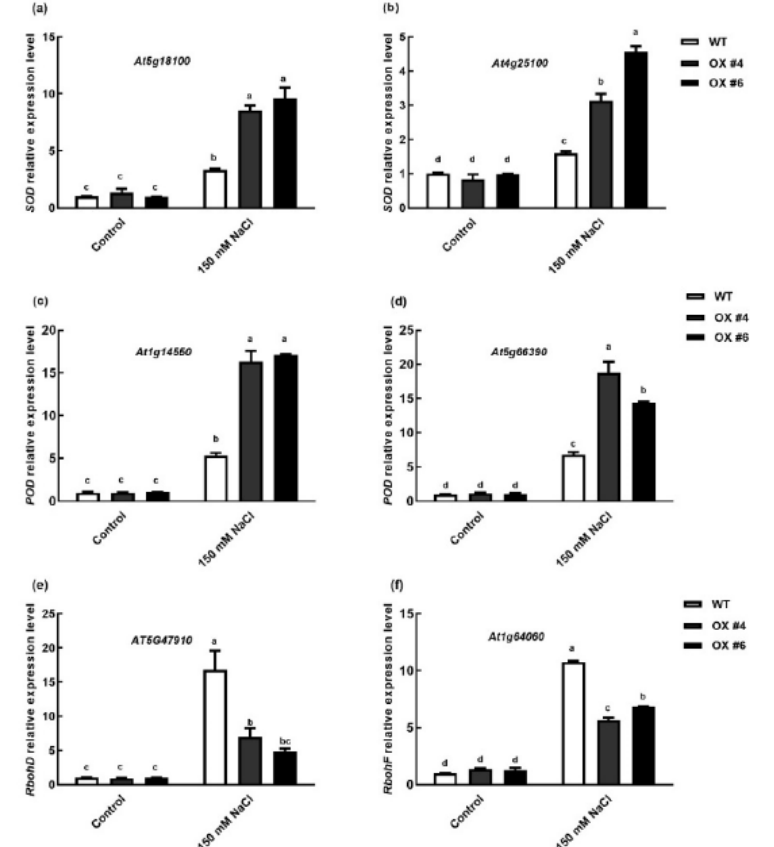
Figure 7. Effects of salt stress on the mRNA levels of SOD , POD , RbohD, and RbohF in the leaves of wild type (WT), BvbHLH93 -overexpression Arabidopsis (OX), atbhlh93 mutant (KO), and transgenic BvbHLH93 in the mutant (CO). ( a , b ) mRNA levels of SOD under control and salt stress (150 mM NaCl) conditions. ( c , d ) mRNA levels of POD under control and salt stress (150 mM NaCl) conditions. ( e , f ) mRNA levels of RbohD and RbohF under control and salt stress (150 mM NaCl) conditions. Different letters indicate significant difference at p < 0.05. Three biological replicates were